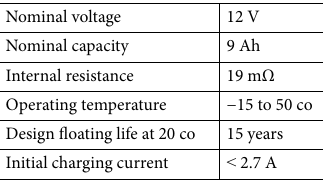
Table 3. The Ultracell UXL9-12 battery datasheet.